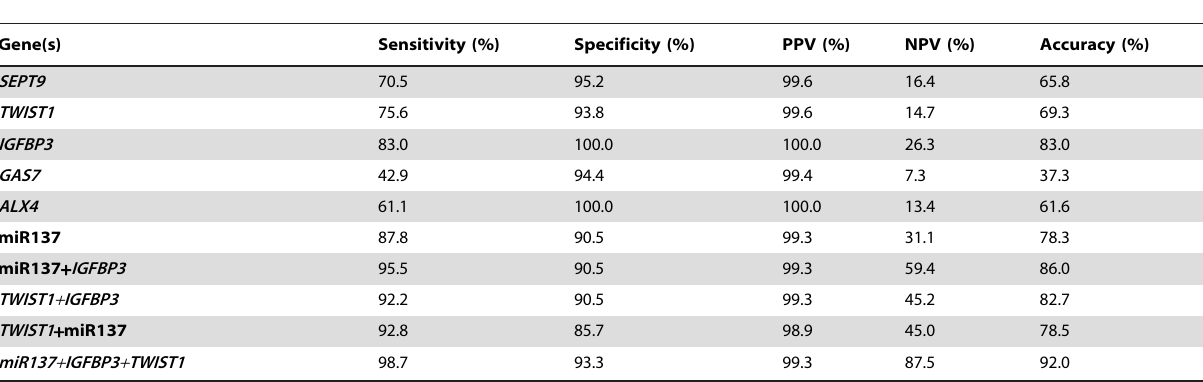
Table 1. Performance Characteristics Of Methylation Markers For The Identification Of Colorectal Cancer.